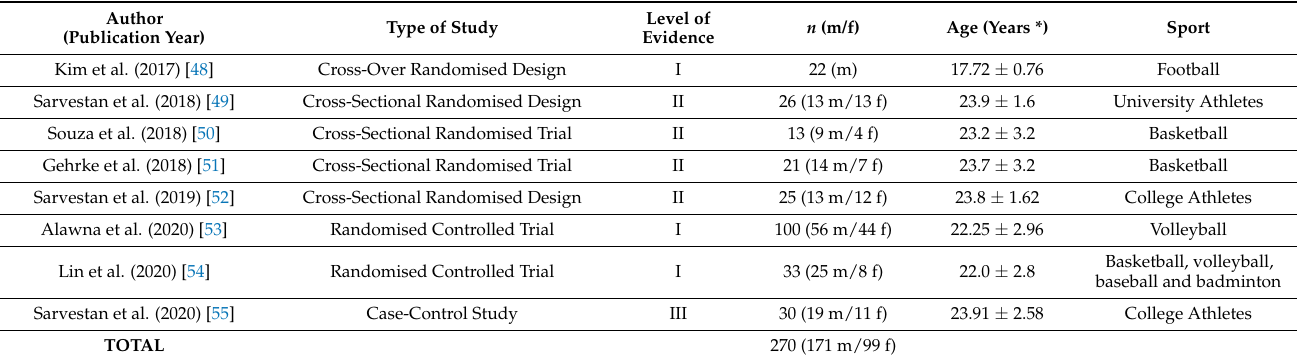
Table 1. Study Characteristics.